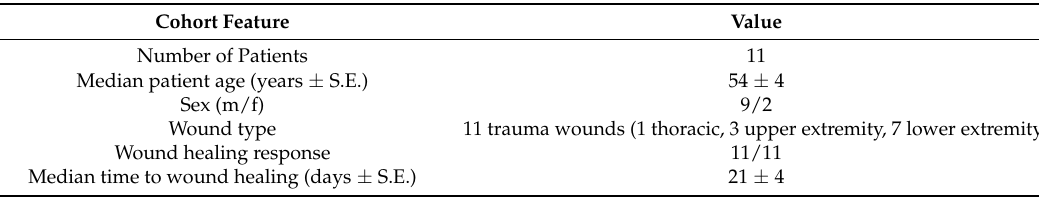
Table 1. Patients enrolled in this